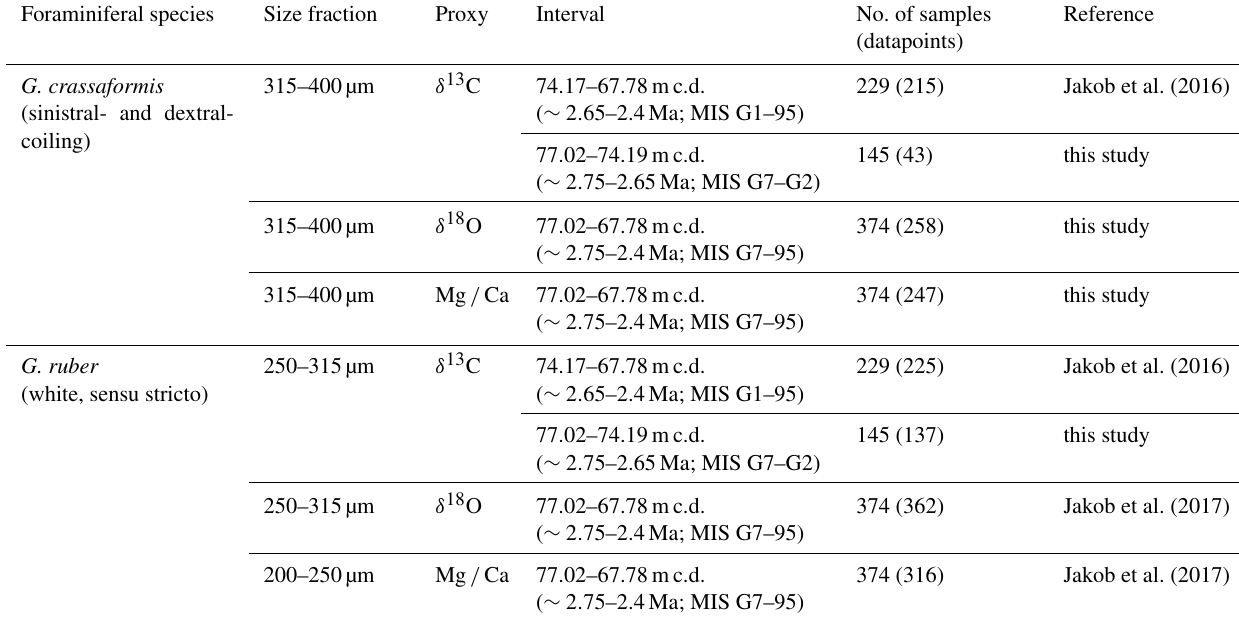
Reference (datapoints)